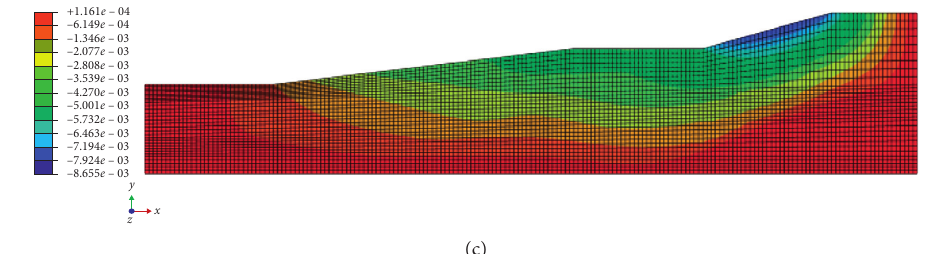
Figure 14: Distributions of horizontal displacement under different rainfall intensities. (a) Rainfall intensity is 40mm/d. (b) Rainfall intensity is 80mm/d. (c) Rainfall intensity is 160mm/d.